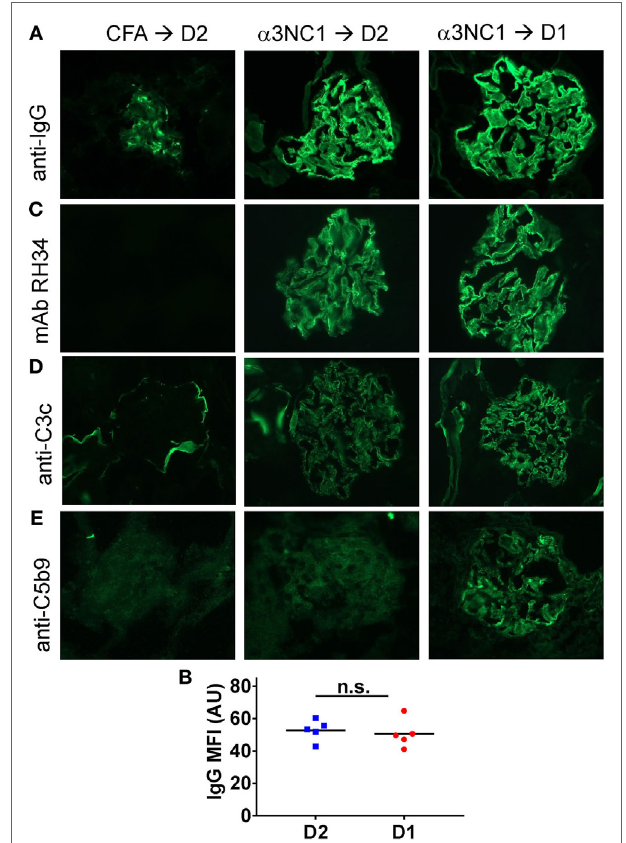
FigUre 2 | Analysis of glomerular immune complexes and complement deposition in D1 and D2 mice immunized with α 3NC1. Kidneys were collected at week 8 post-immunization from adjuvant immunized D2 mice (left), α 3NC1-immunized D2 mice (middle), and α 3NC1-immunized D1 mice (right). (a) Direct immunofluorescence staining shows mouse IgG binding along the glomerular basement membrane (GBM) in α 3NC1-immunized D1 and D2 mice. Control mice show non-specific mesangial deposition of mouse IgG. (B) Mean fluorescence intensity (MFI) of IgG staining, expressed in arbitrary units (AU), was compared in α 3NC1-immunized D2 and D1 mice. The difference was not significant (n.s.) by t test. (c) Indirect immunofluorescence staining with mAb RH34 shows GBM deposition of exogenous antigen in all α 3NC1-immunized mice, which is absent in adjuvant-immunized mice. (D) Direct immunofluorescence staining reveals C3c deposition along the capillary loops in α 3NC1-immunized D1 and D2 mice. In control mice, C3c staining is positive in the Bowman’s capsule and kidney tubules. (e) Indirect immunofluorescence shows capillary loop staining for C5b-9 in α 3NC1-immunized D1 mice. A weak background of non-specific immunofluorescence is observed in adjuvant-immunized and α 3NC1- immunized D2 mice. Original magnification 400 × .